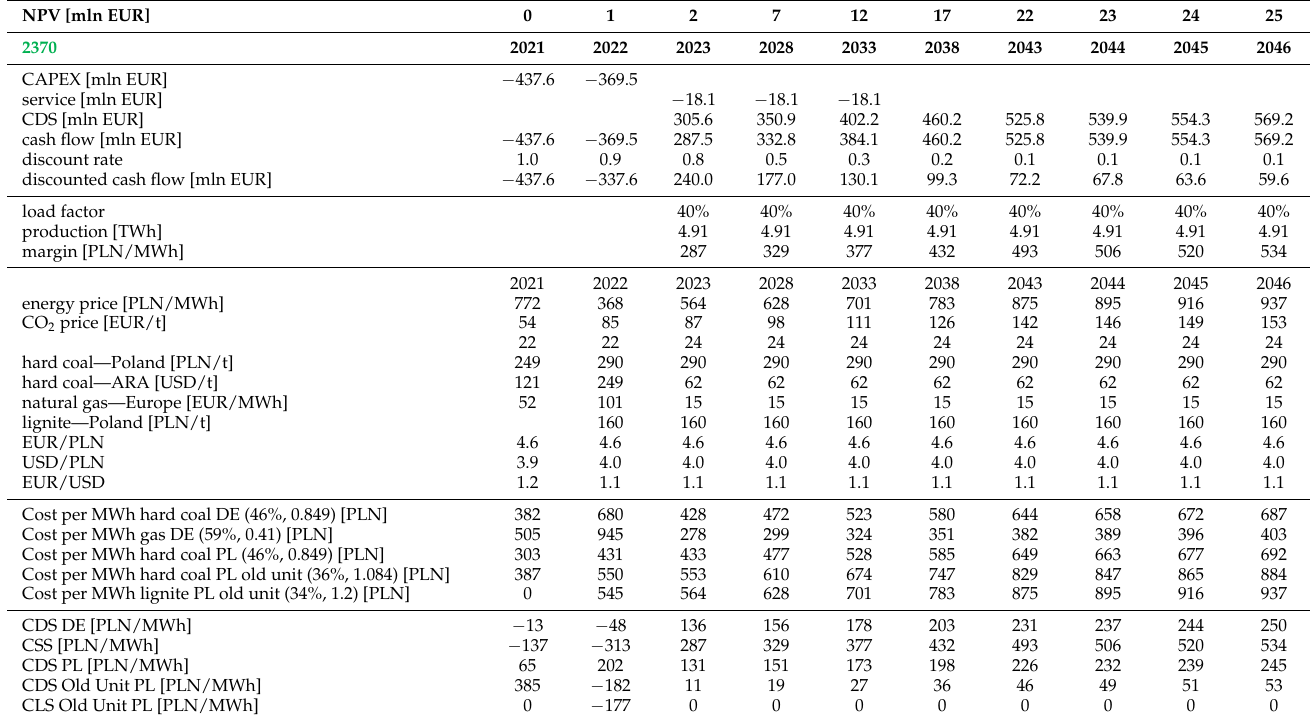
Table 3. Second scenario (source: created by the authors in